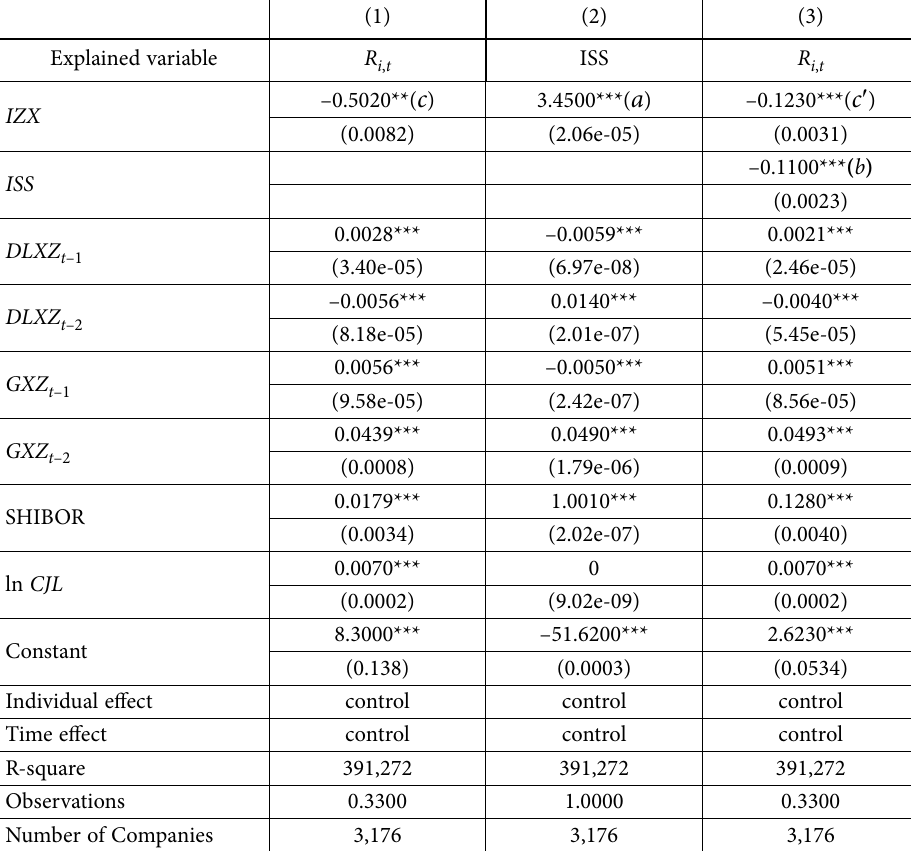
Table 13. Robustness